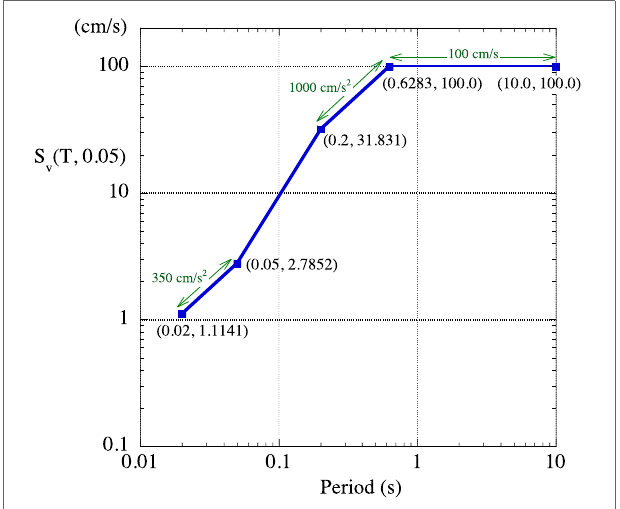
FIGURE 17 | Design velocity response spectrum